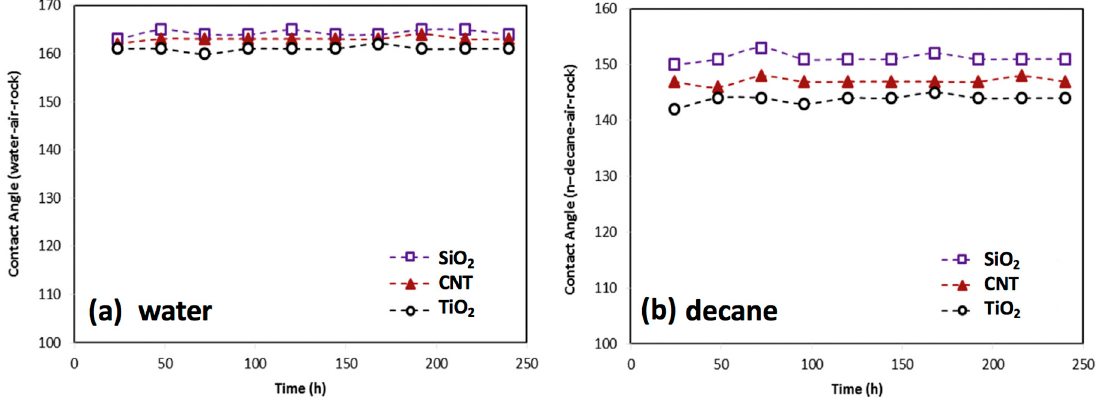
Figure 7. Impact of temperature on gas-wetting performance. Reprinted with permission from [89].